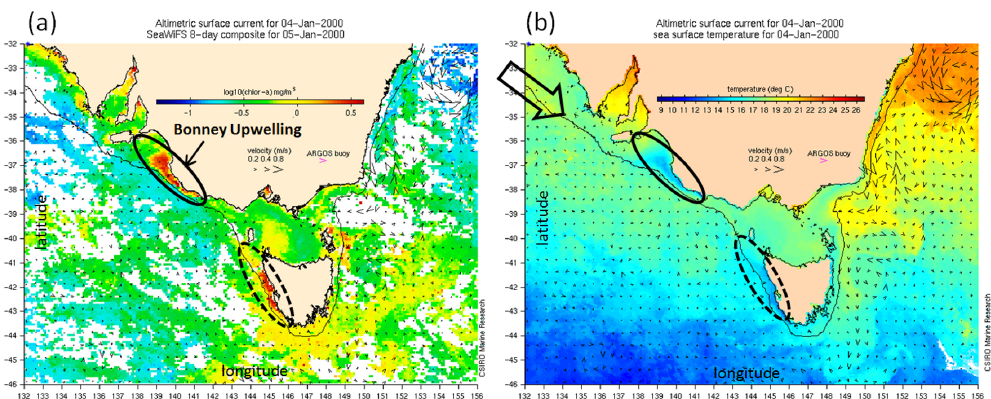
Figure 3. Occurrence of a pronounced coastal upwelling event in early January 2000, evident in satellite-derived distributions of (a) MODIS- OC3 chlorophyll a and (b) sea surface temperature. White regions in panel (a) are missing data due to clouds. The large arrow in panel (b) indicates the pathway of the South Australian Current. Data source: South East Fishery ocean movies, David Griffin, CSIRO, http: //www.marine.csiro.au/~griffin/SEF/.